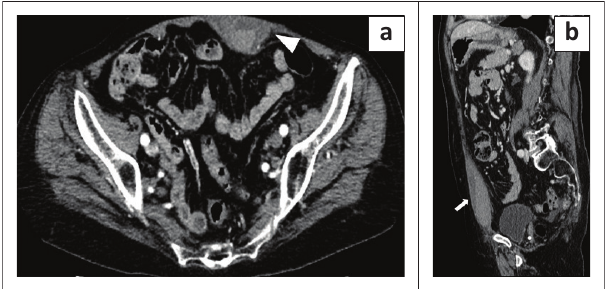
FIGURE 7: A 76-year-old woman with an abdominal wall haematoma diagnosed 8 days after hospital admission. (a) Axial arterial phase image reveals the haematoma in the left rectus muscle (arrowhead). No contrast blushes were detected. (b) Parasagittal venous phase image shows the longitudinal extent of the haematoma in the abdominal wall (arrow), with a layered fluid–fluid blood level. The same patient later developed pulmonary thrombo-embolism (not shown).